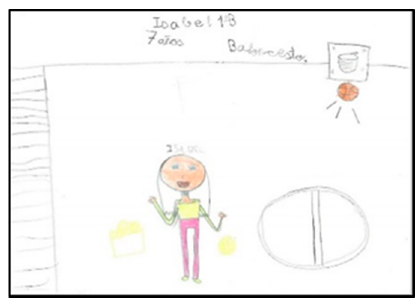
Figure 21. Facial expression. Daniel. 1°B.